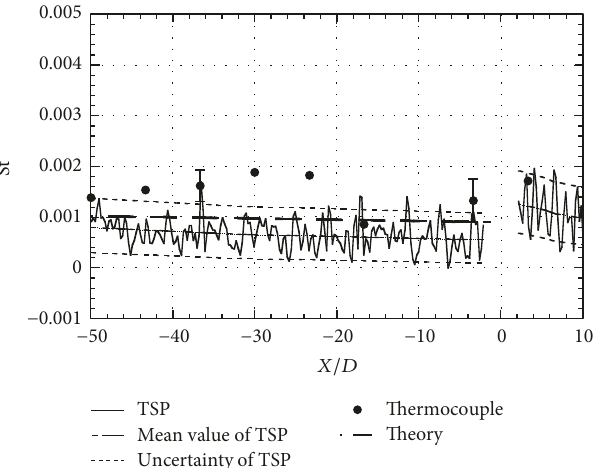
Figure 9: Stanton number profile on 𝑥 -axis obtained by TSP, thermocouples, and Lees’ equation (as a reference) under no- injection condition at 𝑡 = 30 ms. The upper and lower broken lines indicate the range of uncertainty of the TSP measurements. The error bar of thermocouple data indicates ± 1 𝜎 calculated with data obtained in two